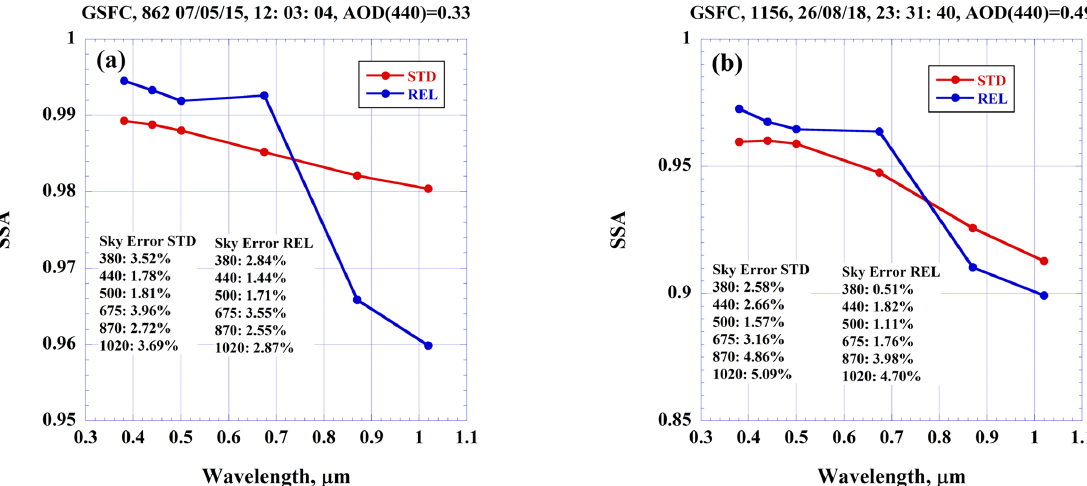
Figure 7. SSA retrieved using V3 assumptions, depicted as STD, and that of REL on the IPRI smoothness constants at the GSFC AERONET site: (a) AOD(440) = 0.33, AE = 1.74 and (b) AOD(440) = 0.49, AE = 1.63.